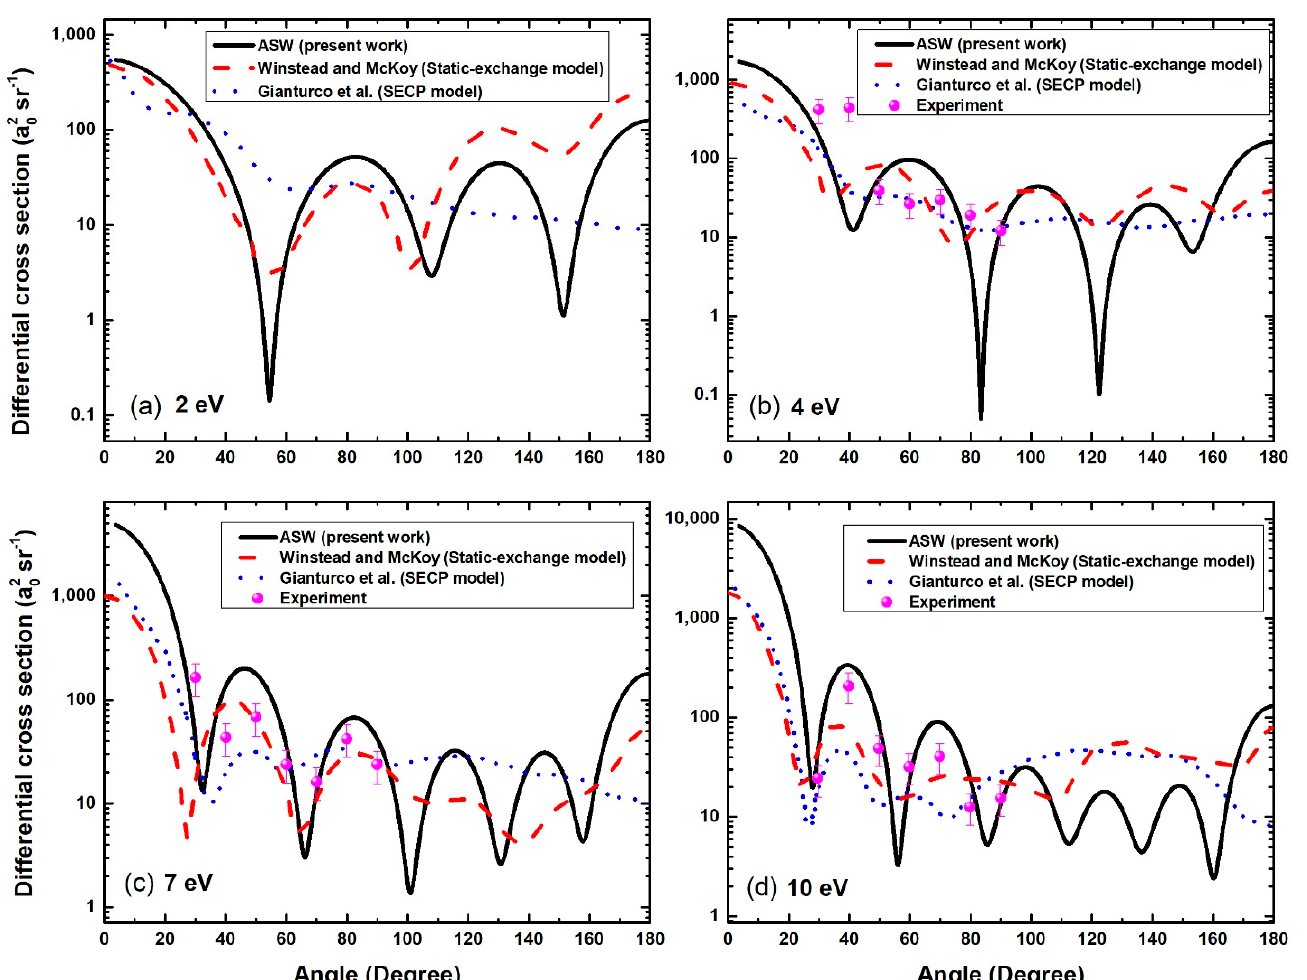
Figure 2. DCS for e-C 60 elastic scattering using ASW potential (black solid line) compared with the results of Winstead and McKoy (red dashed line) [64], Gianturco et al. (blue dotted line) [63], and the experiment by Tanaka et al. [17] for energies ( a ) 2 eV, ( b ) 4 eV, ( c ) 7 eV and ( d ) 10